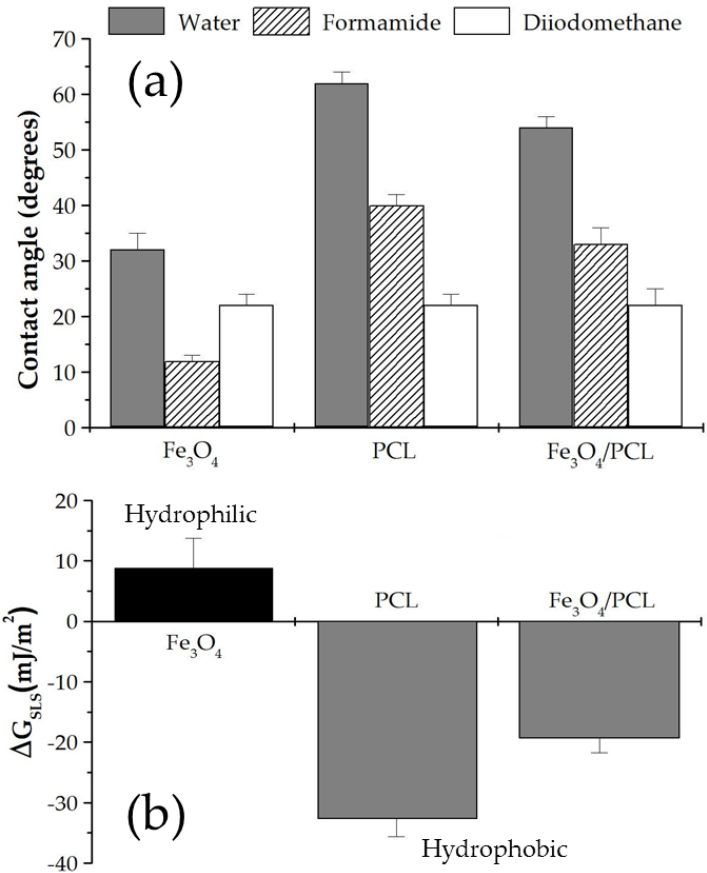
Figure 5. ( a ) Contact angle ( θ , degrees) of water, formamide, and diiodomethane on Fe 3 O 4 , PCL, and Fe 3 O 4 / PCL (of 2:4 Fe 3 O 4 :PCL weight ratio) particle layers, and ( b ) ∆ G SLS (solid–liquid interfacial energy of interaction) values (mJ / m 2 ) and hydrophobic / hydrophilic character of the NPs.